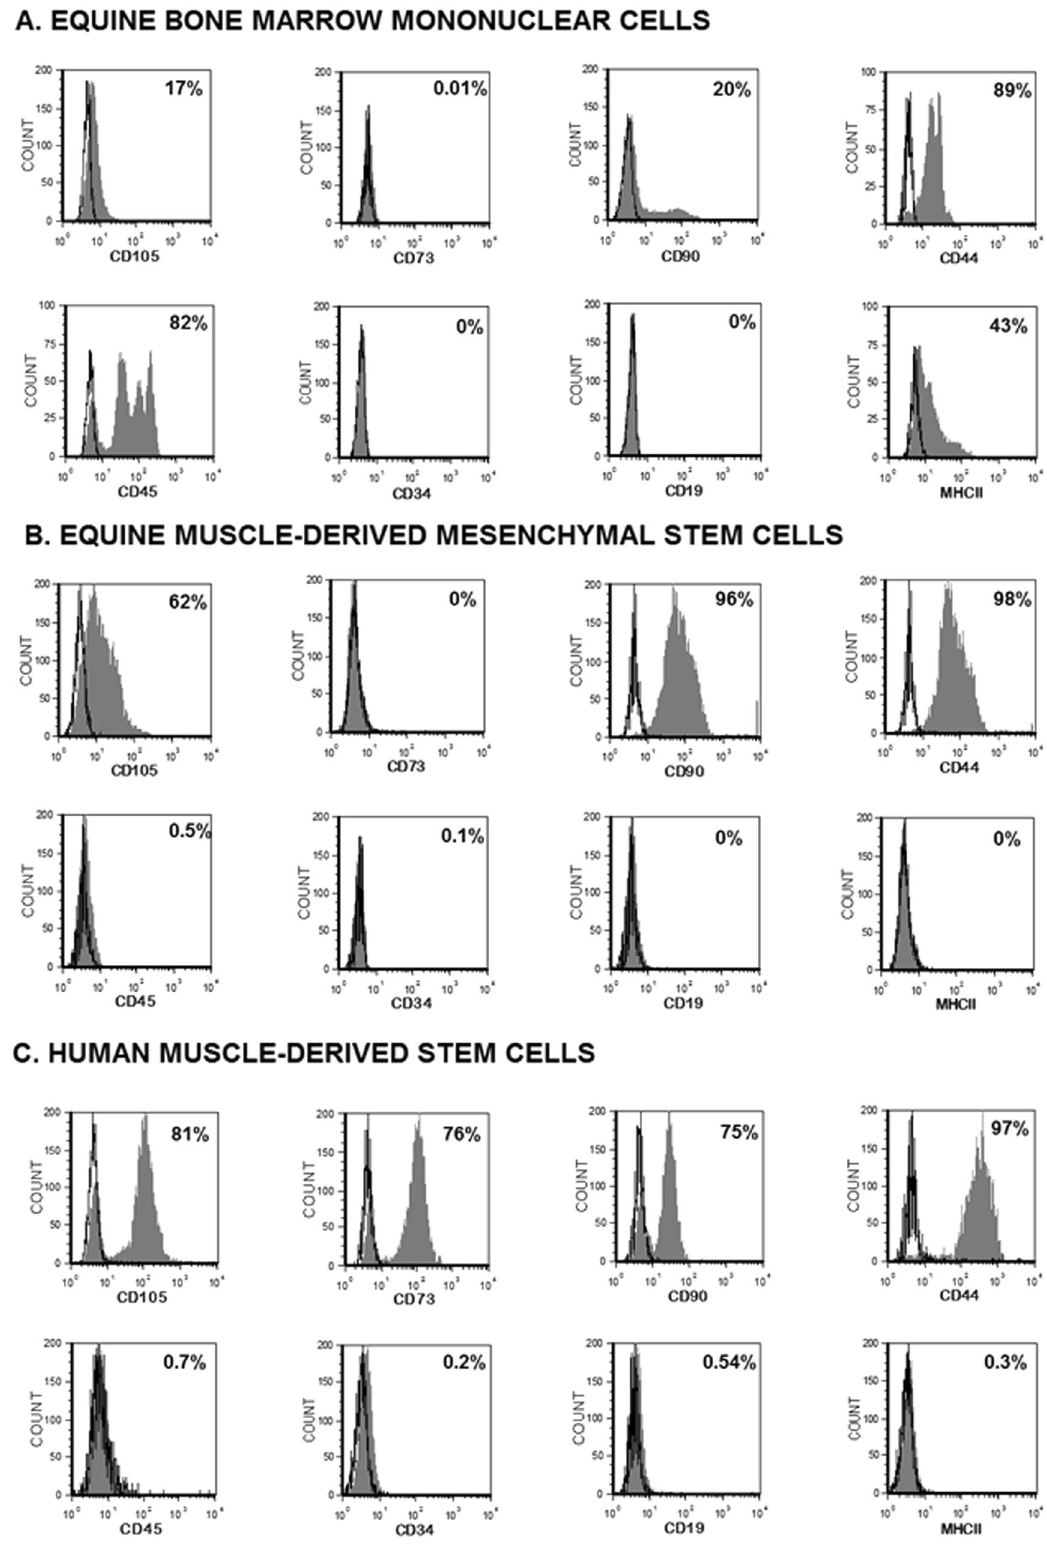
Figure 3. Representative flow cytometry analysis of equine and human cells: ( A ) equine bone marrow mononuclear cells (BM-MNC) ( B ) equine muscle-derived mesenchymal stem cells ( C ) human muscle-derived mesenchymal stem cells. BM-MNC were used to validate the cross-reactivity of antibodies listed in Table 1. Open histograms show nonspecific isotype control staining and solid histograms show specific staining for the indicated marker. Cross-reactivity was not found for CD73, CD34 and CD19